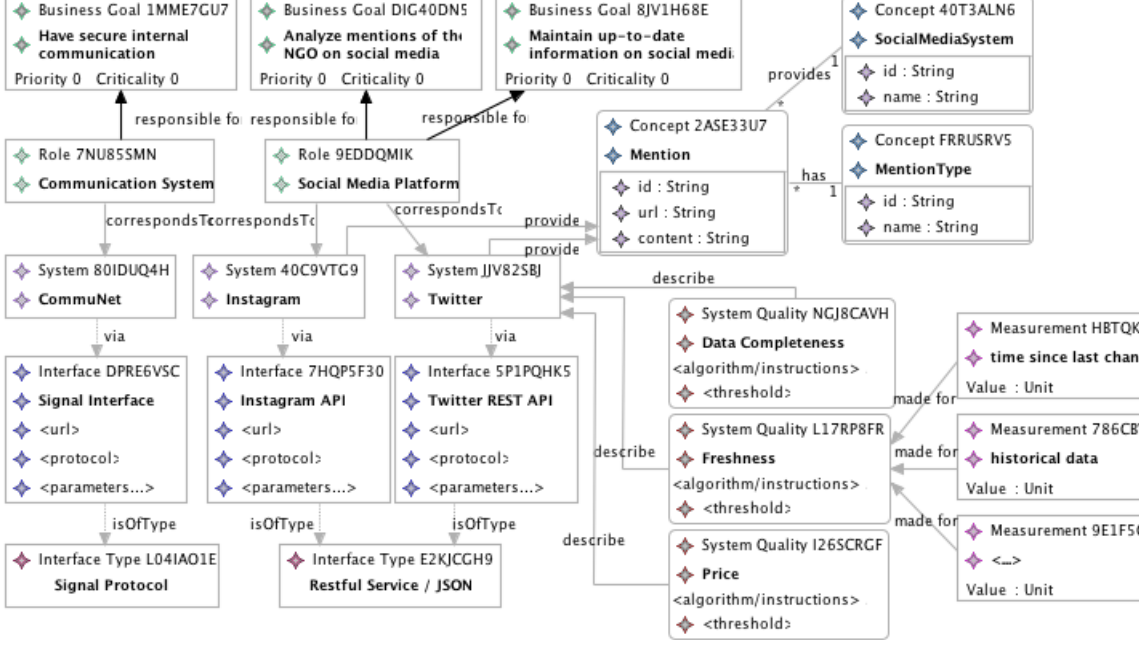
Figure 7. Systems model of the integration solution for the case of Aid&More, including system